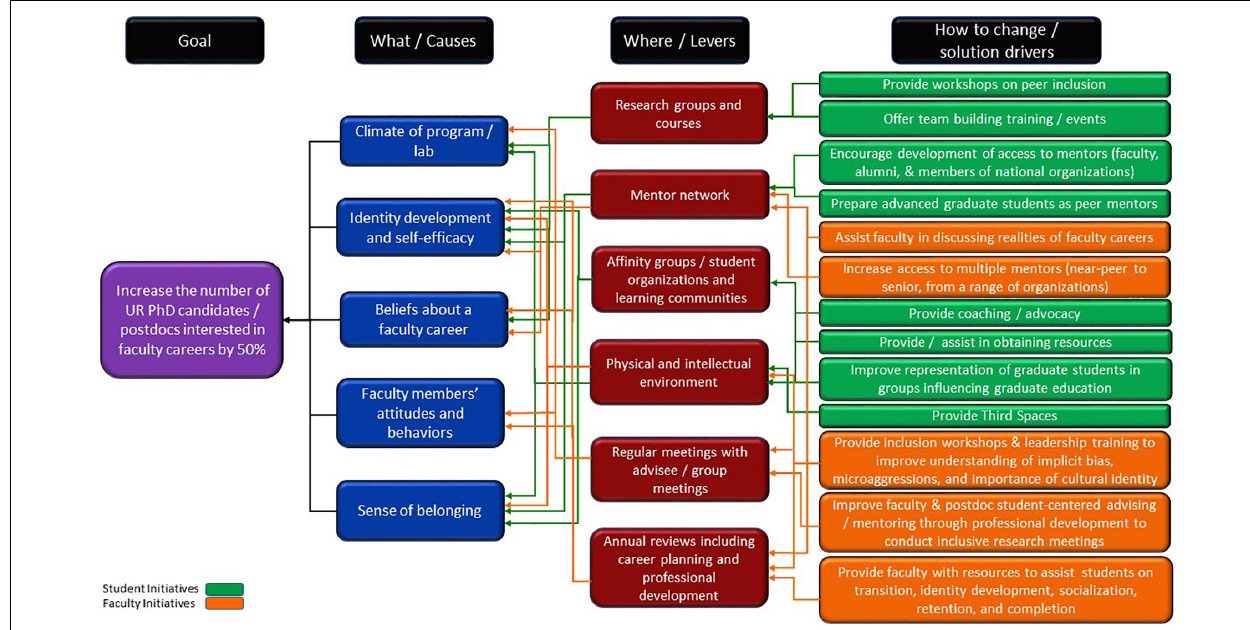
FIGURE 1 | Driver diagram for the CIRTL AGEP